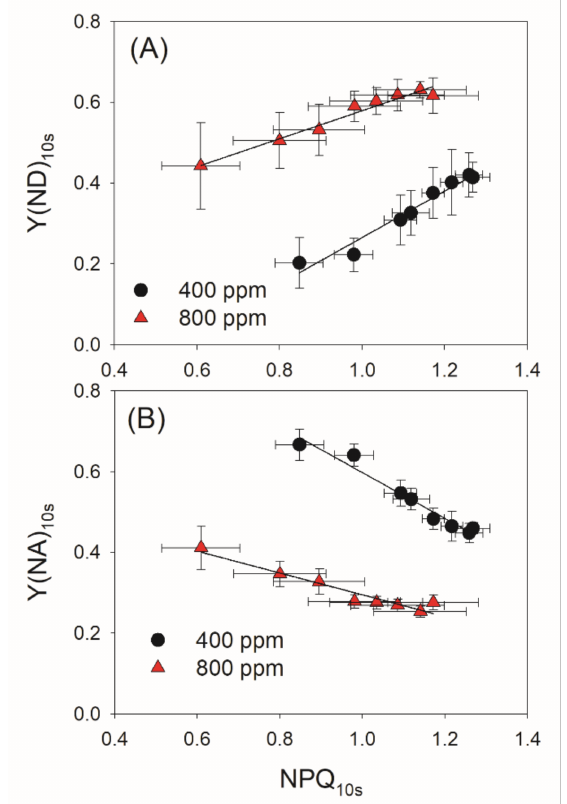
Figure 6. Relationships between NPQ and PSI redox state after transition from low to high light for 10 s in the eight cycles of low/high light. ( A ) Relationship between NPQ 10s and Y(ND) 10s ; ( B ) Relationship between NPQ 10s and Y(NA) 10s . Data are prepared by combining the different time points of Figures 3 and